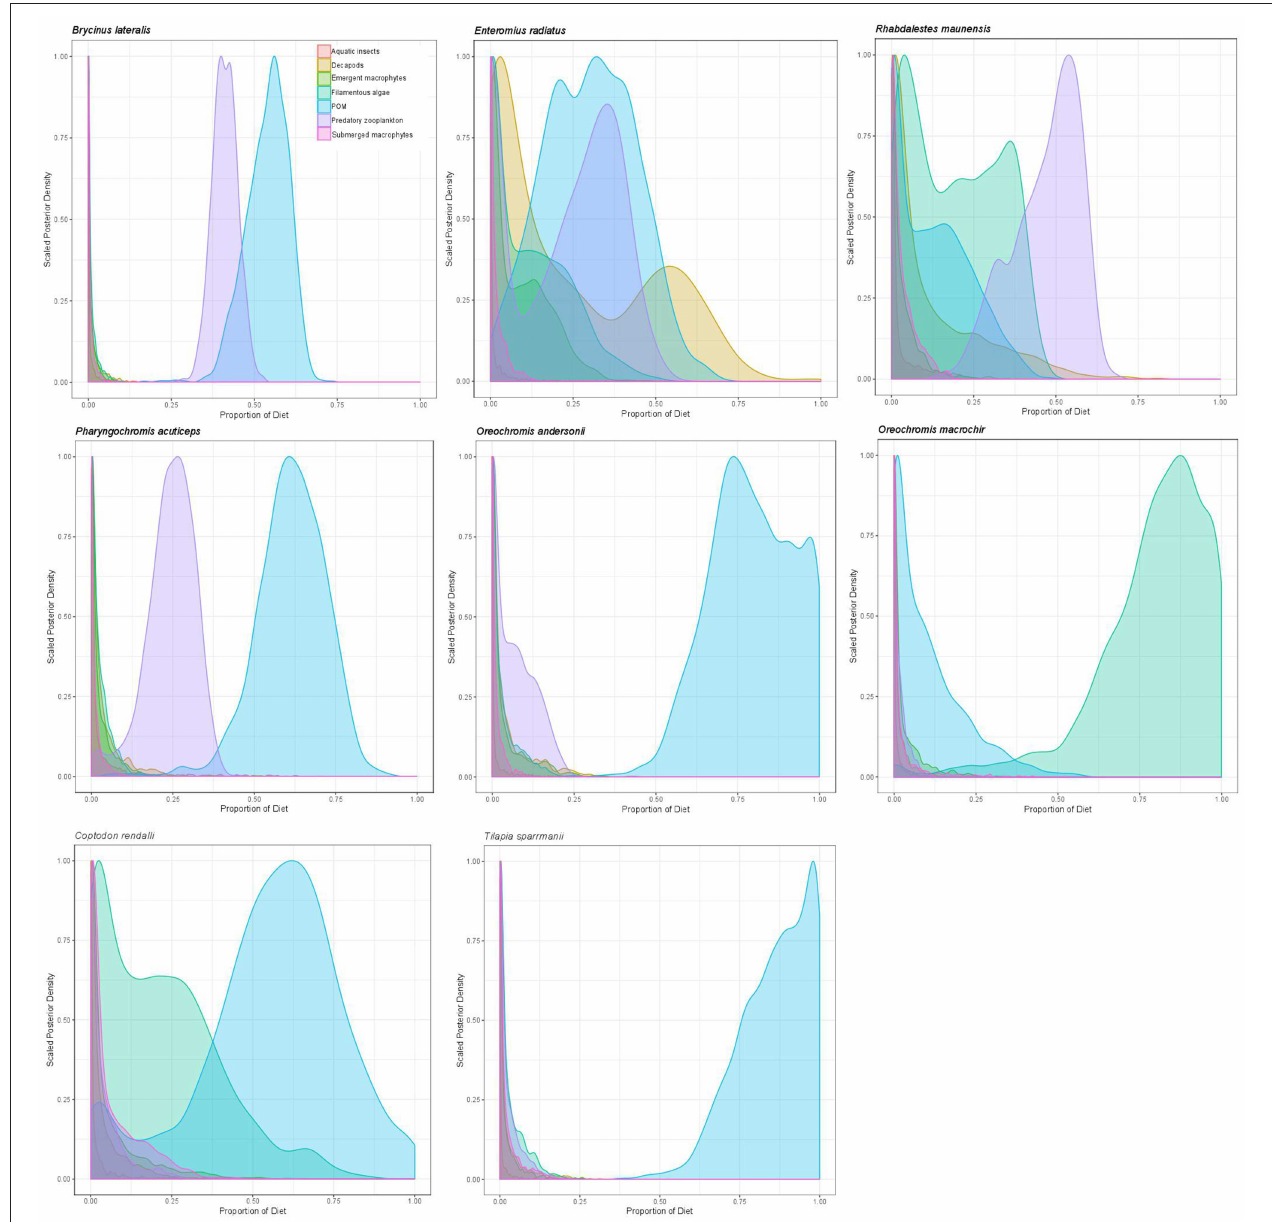
Table 4 ). The trophic positions of individual fish species within important consumer groups were examined further to elucidate interspecific trophic